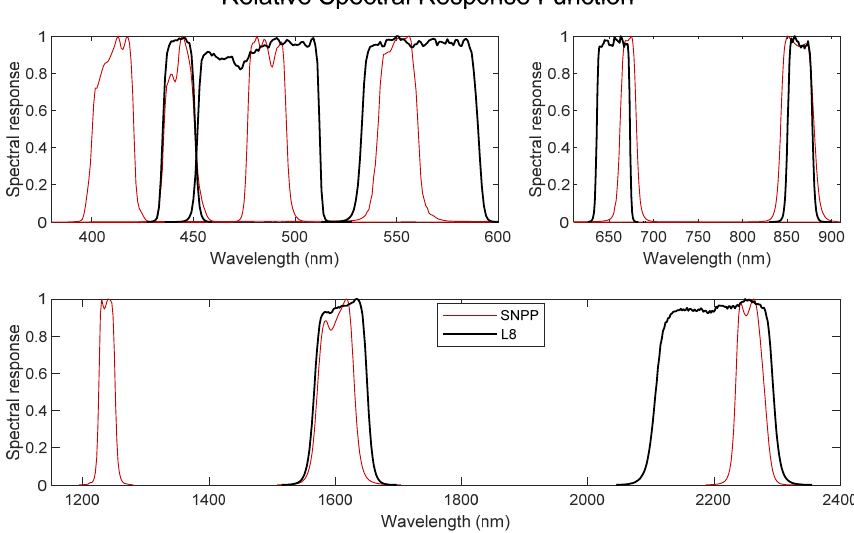
Figure 2. Relative spectral response functions of Landsat 8/OLI, SNPP/VIIRS.